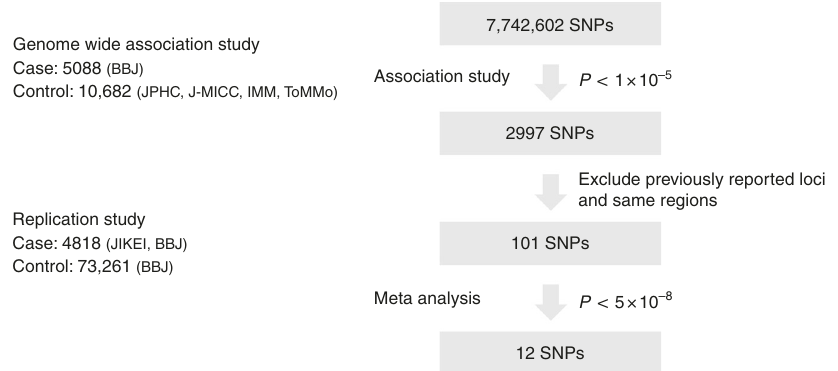
Fig. 1 Scheme for study design and screening results. First, we conducted discovery GWAS followed by imputation using 1000 Genomes Project Phase1 as a reference. Of the 2997 SNPs that were associated with PCa ( P < 1 × 10 − 5 ), top 101 SNPs excluding those residing in previously reported loci were evaluated in the replication study using an independent cohort. A total of 12 SNPs were signi fi cantly associated with PCa ( P < 5 × 10 − 8 ) after meta-analysis of discovery and